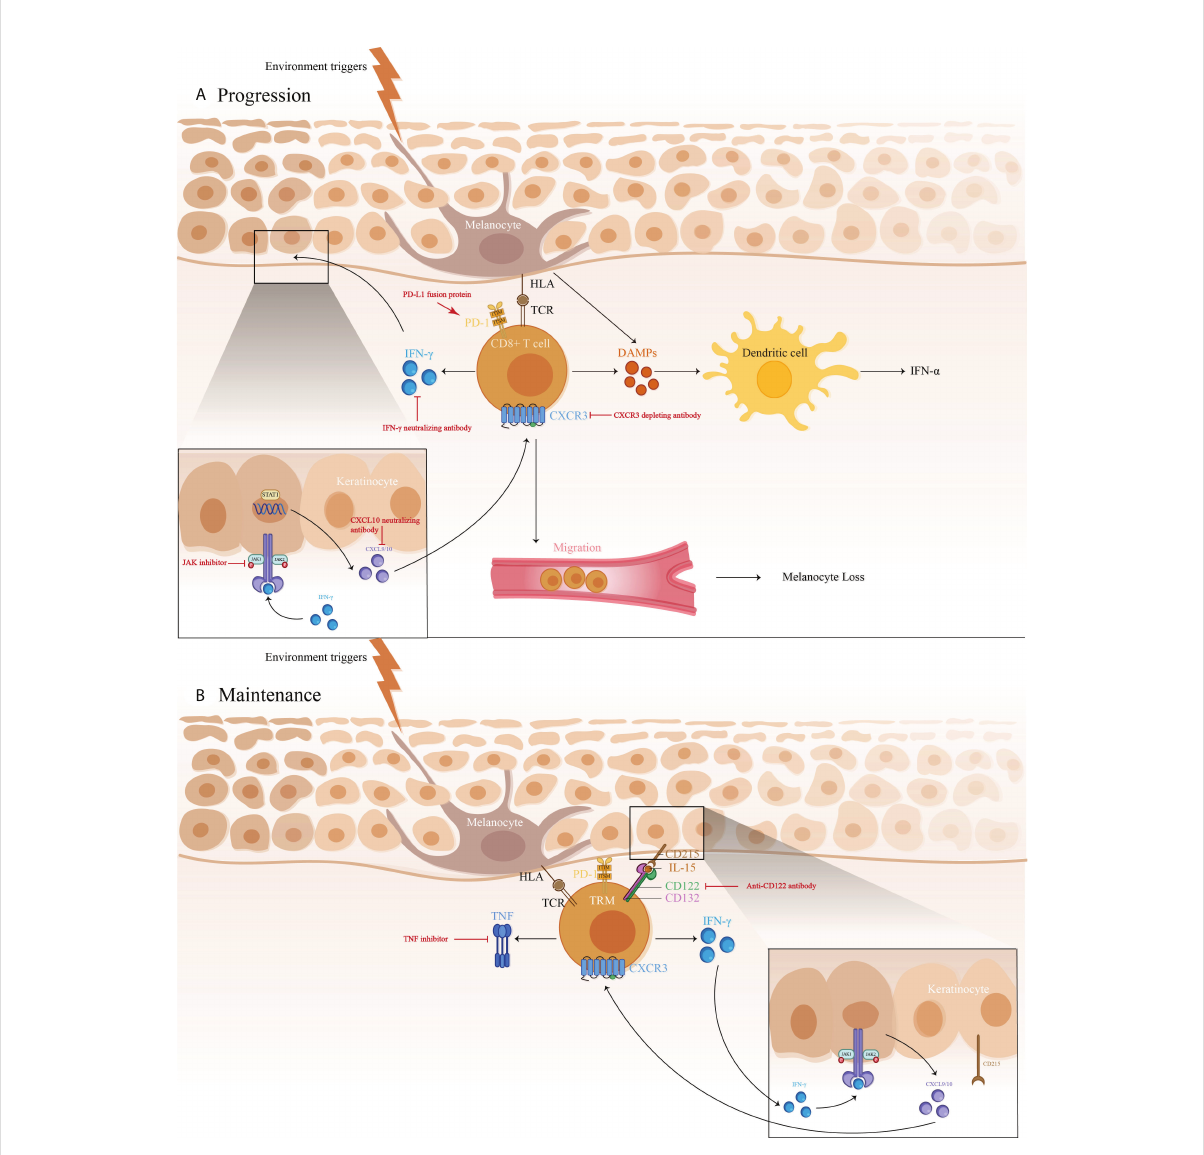
FIGURE 1 1) The immune pathogenesis of vitiligo: (A) CD8 + T cell expression of IFN- g in vitiligo lesions activated the JAK/STAT pathway after binding to IFN- g receptor, thus facilitating the release of CXCL9/10. The binding of CXCL9/10 to CXCR3 increased CXCR3+T cells recruitment; (B) Maintenance of vitiligo lesions was in fl uenced by the function of IL-15-dependent TRM cells, which produce IFN- g and TNF- a . 2)Targeted therapeutic interventions in vitiligo mainly include therapies targeting IFN- g -CXCL9/10-CXCR3 axis (IFN- g neutralizing antibody, CXCL10 neutralizing antibody, and CXCR3 depleting antibody, as well as JAK inhibitors), anti-CD122 antibody (IL-15 receptor subunit) to decrease IFN- g production and deplete autoreactive CD8 + TRM cells, TNF inhibitor to inhibit autoantibody production, and PD-L1 fusion protein to reduce the numbers of melanocyte-reactive T